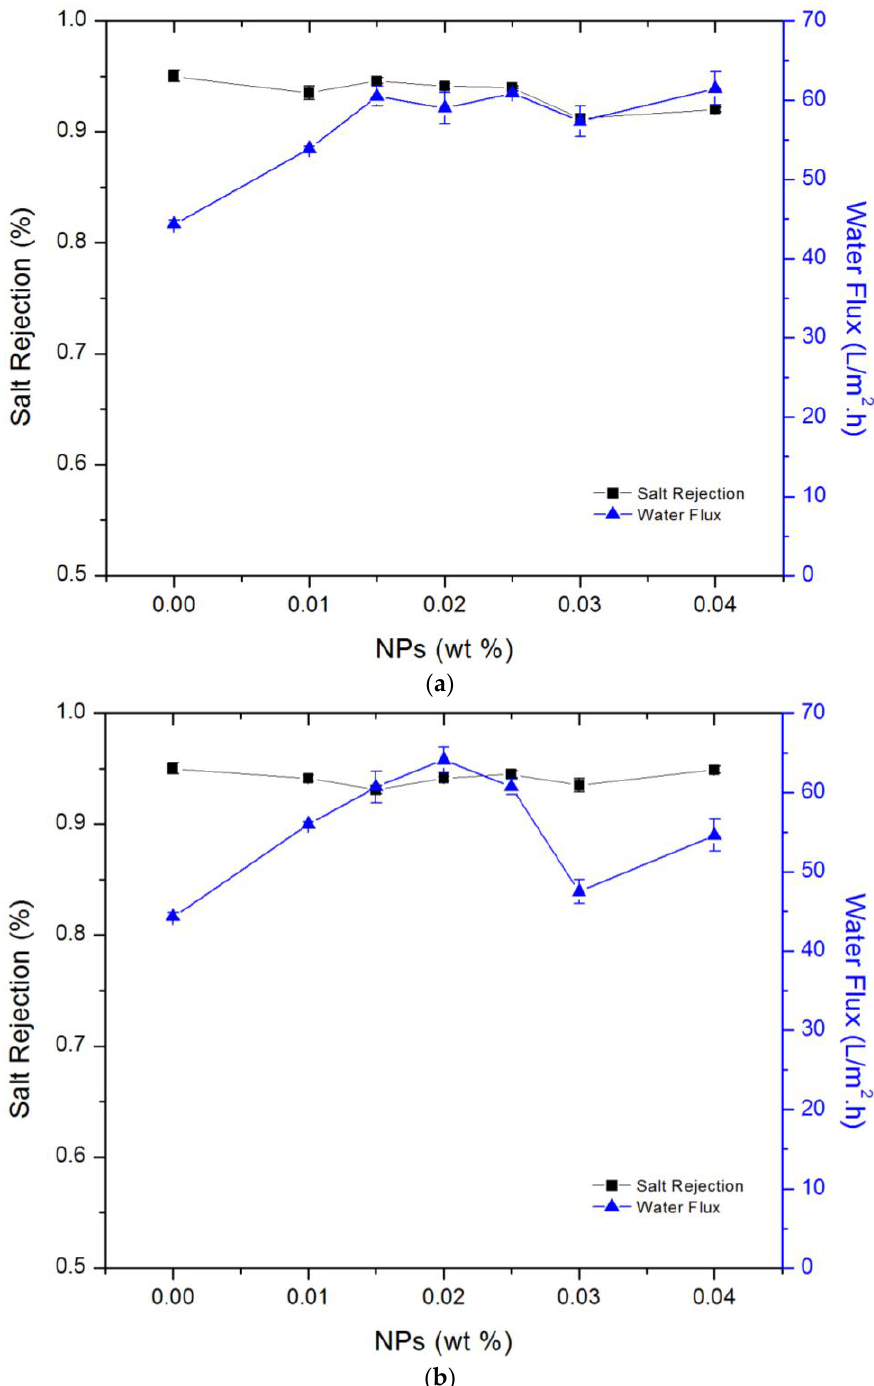
Figure 6. ( a ) Salt rejection and water flux for filling NPs in TMC solution; ( b ) Salt rejection and water flux for adding NPs to MPD solution, under operation conditions of 2068 kPa and 25 °C.